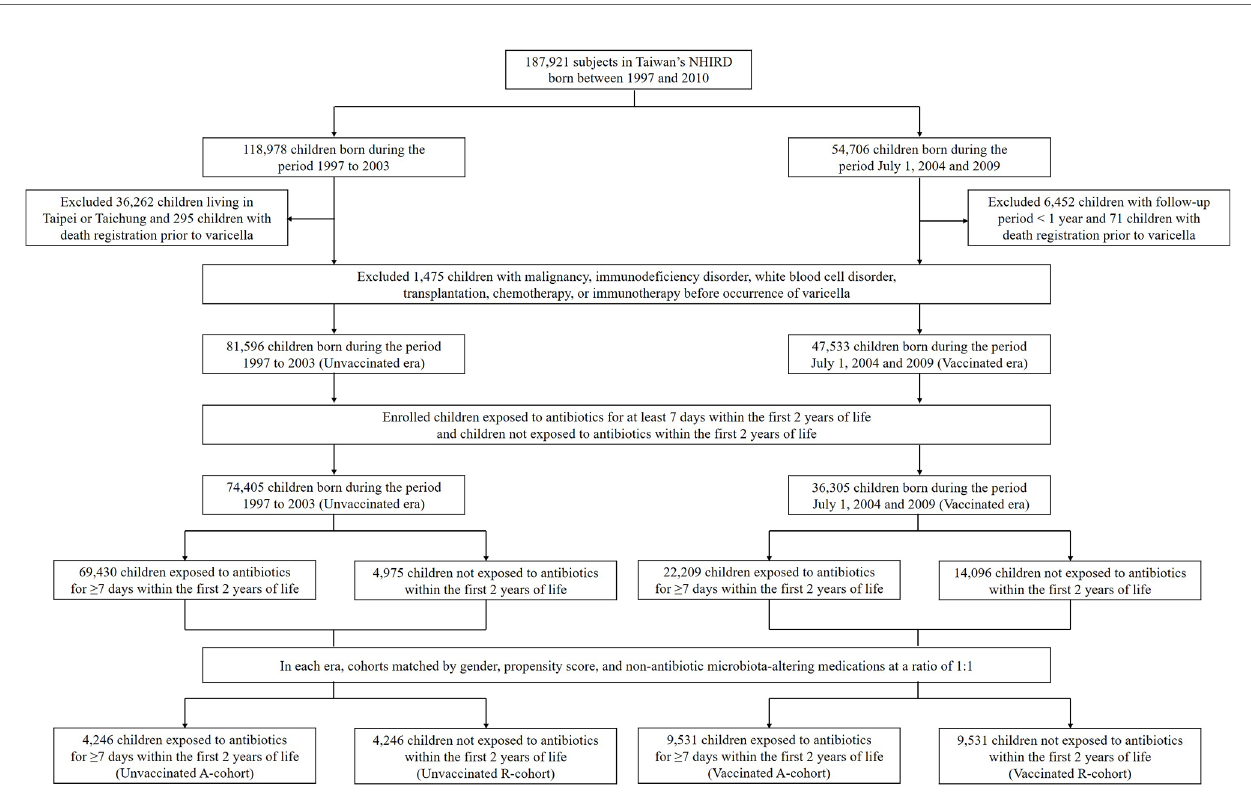
FIGURE 1 | Flow chart of the patient selection process. NHIRD, National Health Insurance Research Database; A-cohort, antibiotic cohort; R-cohort, reference